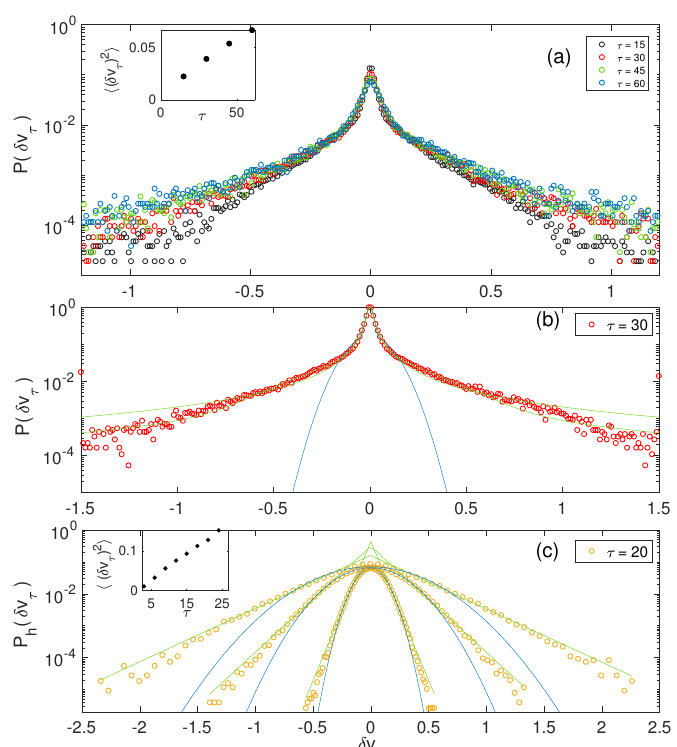
Figure 18. Inhomogeneous plasma with ∆ n = 0.01. ( a ): Typical probability distribution functions P ( δ v τ ) , in logarithmic scale, for different values of τ = 15 (black), 30 (red), 45 (green), and 60 (blue). Insert: Variation of (cid:104) ( δ v τ ) 2 (cid:105) with τ . ( b ): Typical probability distribution function P ( δ v τ ) , in logarithmic scale, for τ = 30 and another time interval ∆ T than ( a ). The calculated probabilities are shown by circles whereas the interpolation functions at moderate and large δ v τ are the sum of two Gaussians (blue curve) and the sum of a Gaussian and a power function (green curves). Homogeneous plasma ( ∆ n = 0). ( c ) Homogeneous plasma: Typical probability distribution function P h ( δ v τ ) , in logarithmic scale, for τ = 20. Insert: Variation of (cid:104) ( δ v τ ) 2 (cid:105) with τ . The calculated probabilities are shown by circles whereas the interpolation functions at moderate and large δ v τ are Gaussian (blue curves) and exponential functions (green curves). Main parameters are: v b / v T = 18, n b / n 0 = 5 × 10 − 5 . The velocity increments δ v τ are normalized by the plasma thermal velocity v T